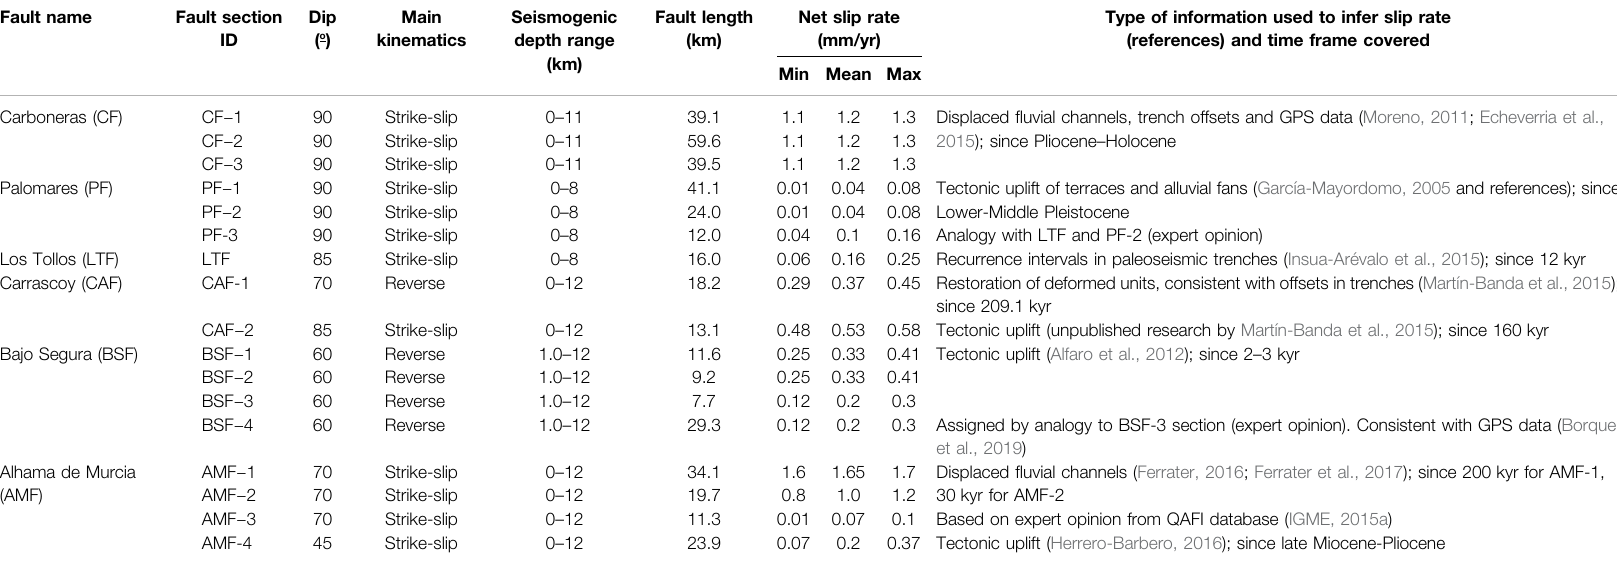
TABLE 1 | Fault input data used tocalculate the earthquake ratesof theEBSZ fault system with theSHERIFS approach in the fault source modeling. The sources of information and references from where fault slip rate data are extracted are speci fi ed (see details in Gómez-Novell et al., 2020). Other fault parameters are extracted from the QAFI v.3. Database (IGME, 2015a; García-Mayordomo et al., 2017). See the map in Figure 2A for the location of each fault section mentioned in the table. Adapted from Gómez-Novell et al., 2020.